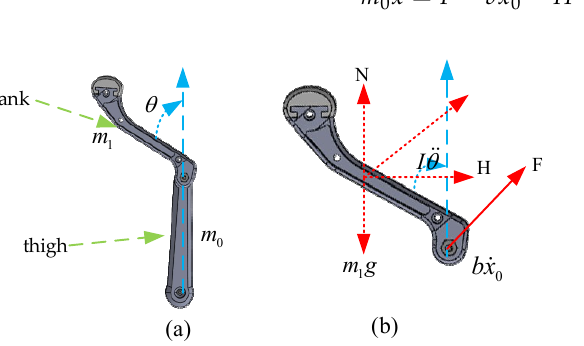
Figure 3. The kinematic model of single-leg swing of a quadruped robot. ( a ) A single-legged model of a quadruped robot. ( b ) Schematic diagram of the force analysis of the lower leg. Among them, x 0 is the horizontal position of the knee joint of the quadruped